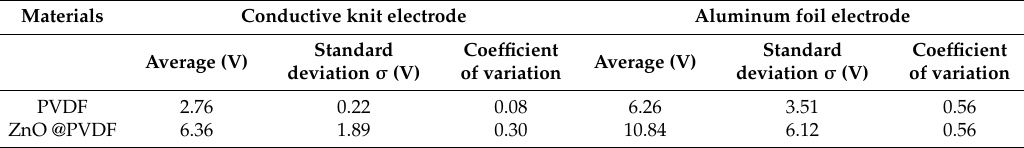
Figure 6. Open-circuit voltage measurements under 0.10 MPa impact of 1 Hz frequency: ( a ) conductive knitted fabric electrode nanogenerator; ( b ) aluminum foil electrode nanogenerator. The black lines are from PVDF, while the red lines from ZnO@PVDF. Table 1. Open-circuit voltages for piezoelectric samples under 0.10 MPa impact of 1 Hz frequency.